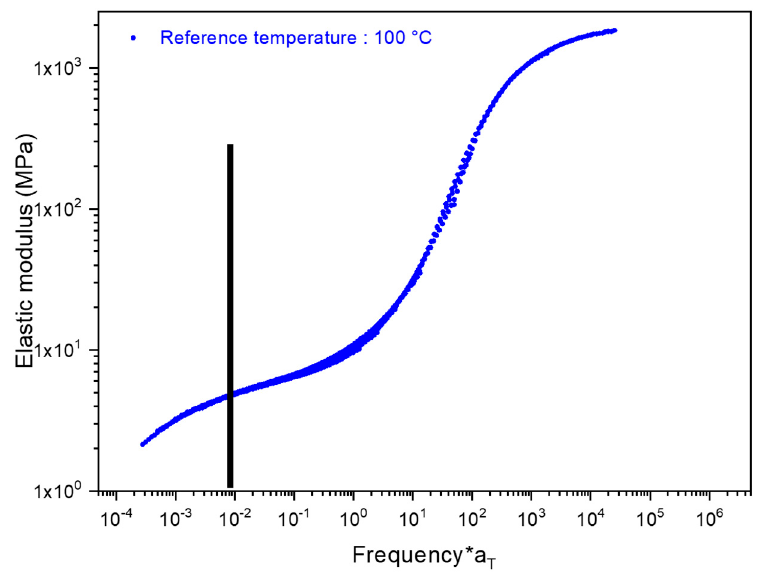
Figure 1. PEF master curve obtained for a reference temperature of 100 °C. The stretching settings have been selected from a equivalent strain rate of 10 -2 s -1 represented by the black line.